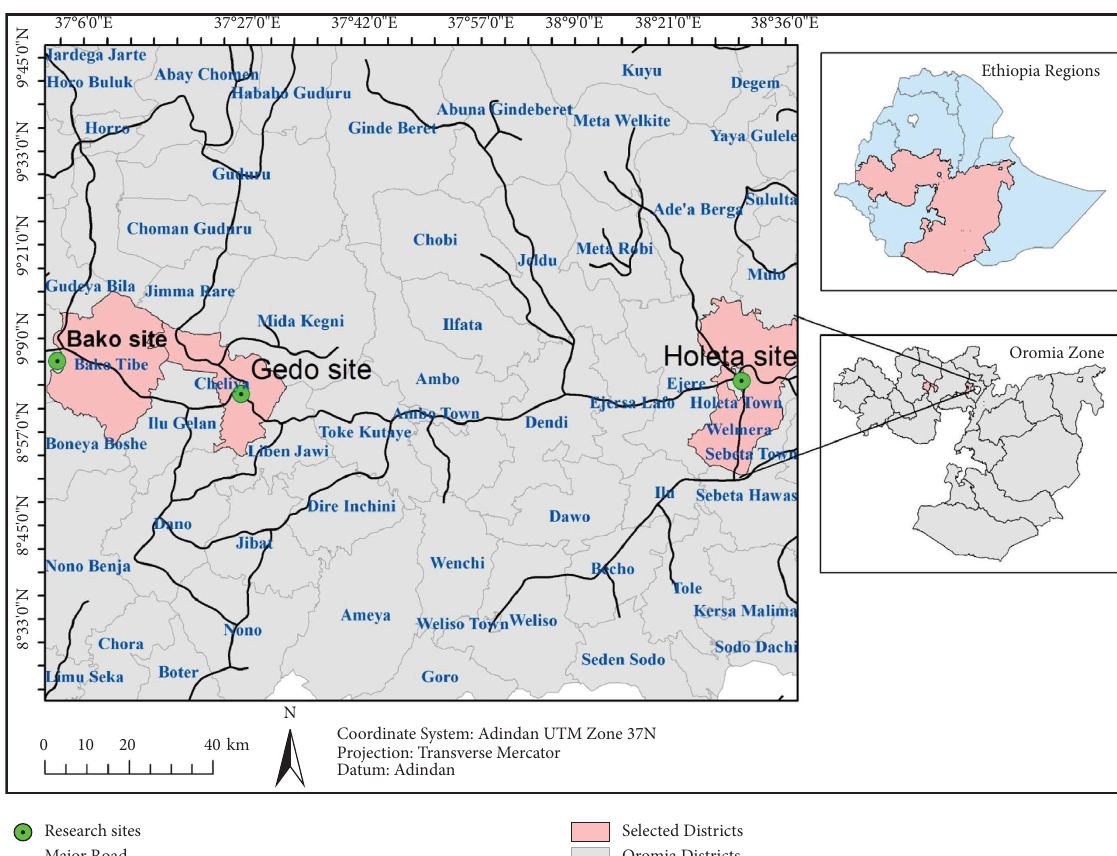
Figure 1: A map of the study